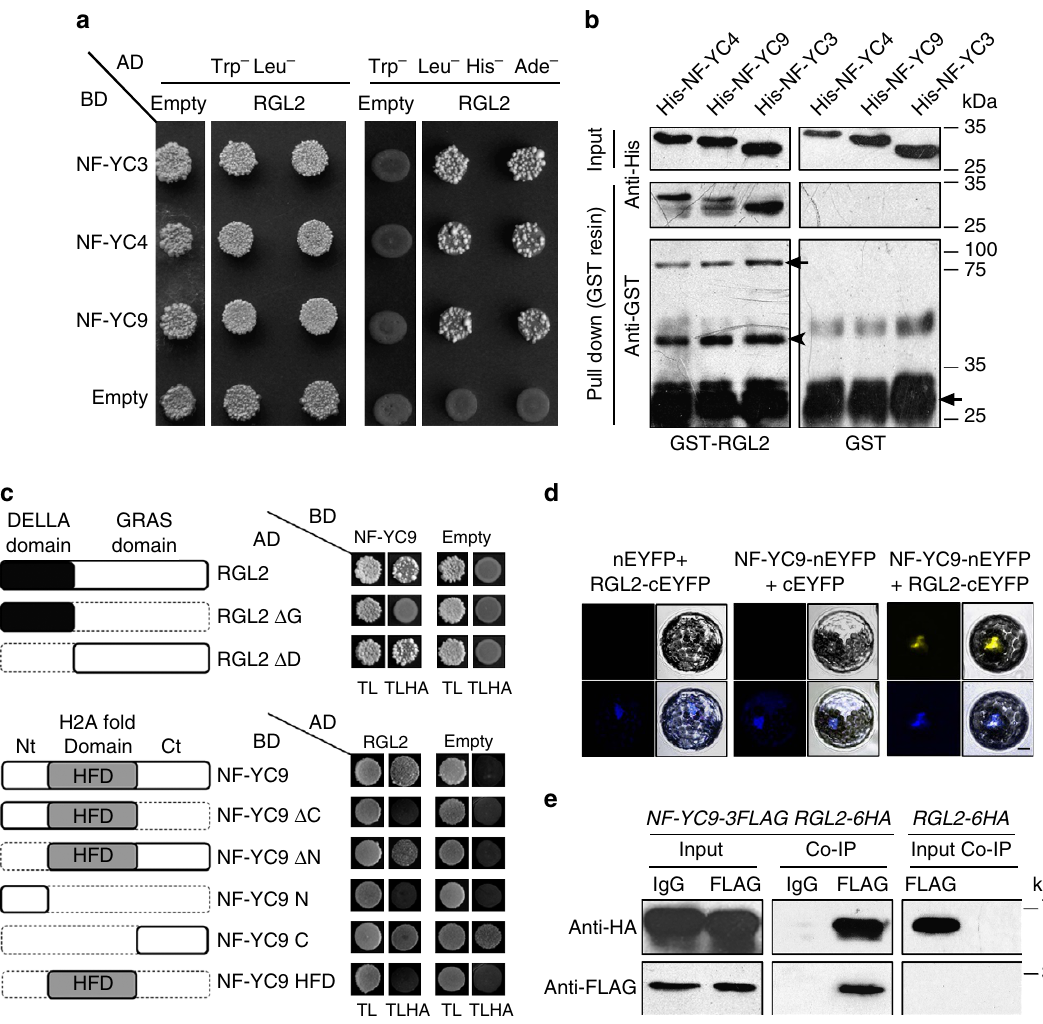
Figure 2 | NF-YCs interact with RGL2 in vitro and in vivo . ( a ) Yeast two-hybrid assays show the interactions between RGL2 and NF-YCs. Transformed yeast cells were grown on SD/-Trp/-Leu/-His/-Ade and SD/-Trp/-Leu medium. ( b ) Pull-down assays show the direct interaction between His-NF-YCs and GST-RGL2 fusion proteins in vitro . His-NF-YC proteins were incubated with immobilized GSTor GST-RGL2 proteins, and immunoprecipitated fractions were detected by anti-His and anti-GST antibodies, respectively. Arrows indicate the specific bands of GST-RGL2 or GST, while arrowhead indicates the nonspecific bands. ( c ) Sketches show the domains of NF-YCs and RGL2 and their various deletions. Yeast two-hybrid assays show the interactions between RGL2, NF-YCs and their derivatives. Transformed yeast cells were grown on SD/-Trp/-Leu/-His/-Ade (TLHA) and SD/-Trp/-Leu (TL) medium. ( d ) BiFC analysis of interaction between NF-YC9-nEYFP and RGL2-cEYFP in Arabidopsis mesophyll protoplast. DAPI staining was used as the nucleus indicator. Scale bar, 10 m m. ( e ) In vivo interaction of NF-YC9 and RGL2 in Arabidopsis . Plant nuclear extracts from PAC-treated seeds of nf-yc9 NF-YC9:NF-YC9-3FLAG rgl2 pRGL2:RGL2-6HA were immunoprecipitated by either anti-FLAG antibody or preimmune serum (IgG). The co-immunoprecipitated proteins were detected by anti-FLAG and anti-HA